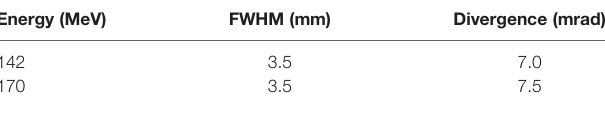
TABLE 7 | Initial ion beam optics (FWHM and divergence at the vacuum exit window) used for the Monte Carlo simulations for 142 and 170 proton beams. Energy